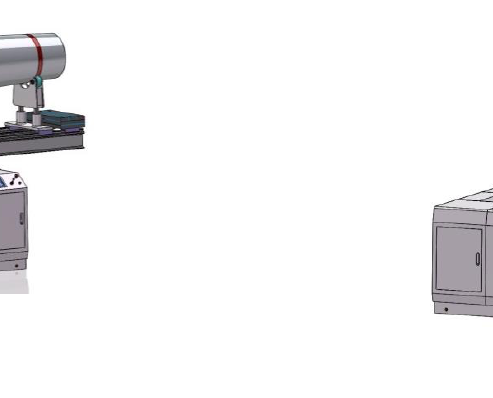
5 of 16 Figure 3. Schematic diagram of measuring MOI by torsional pendulum method.